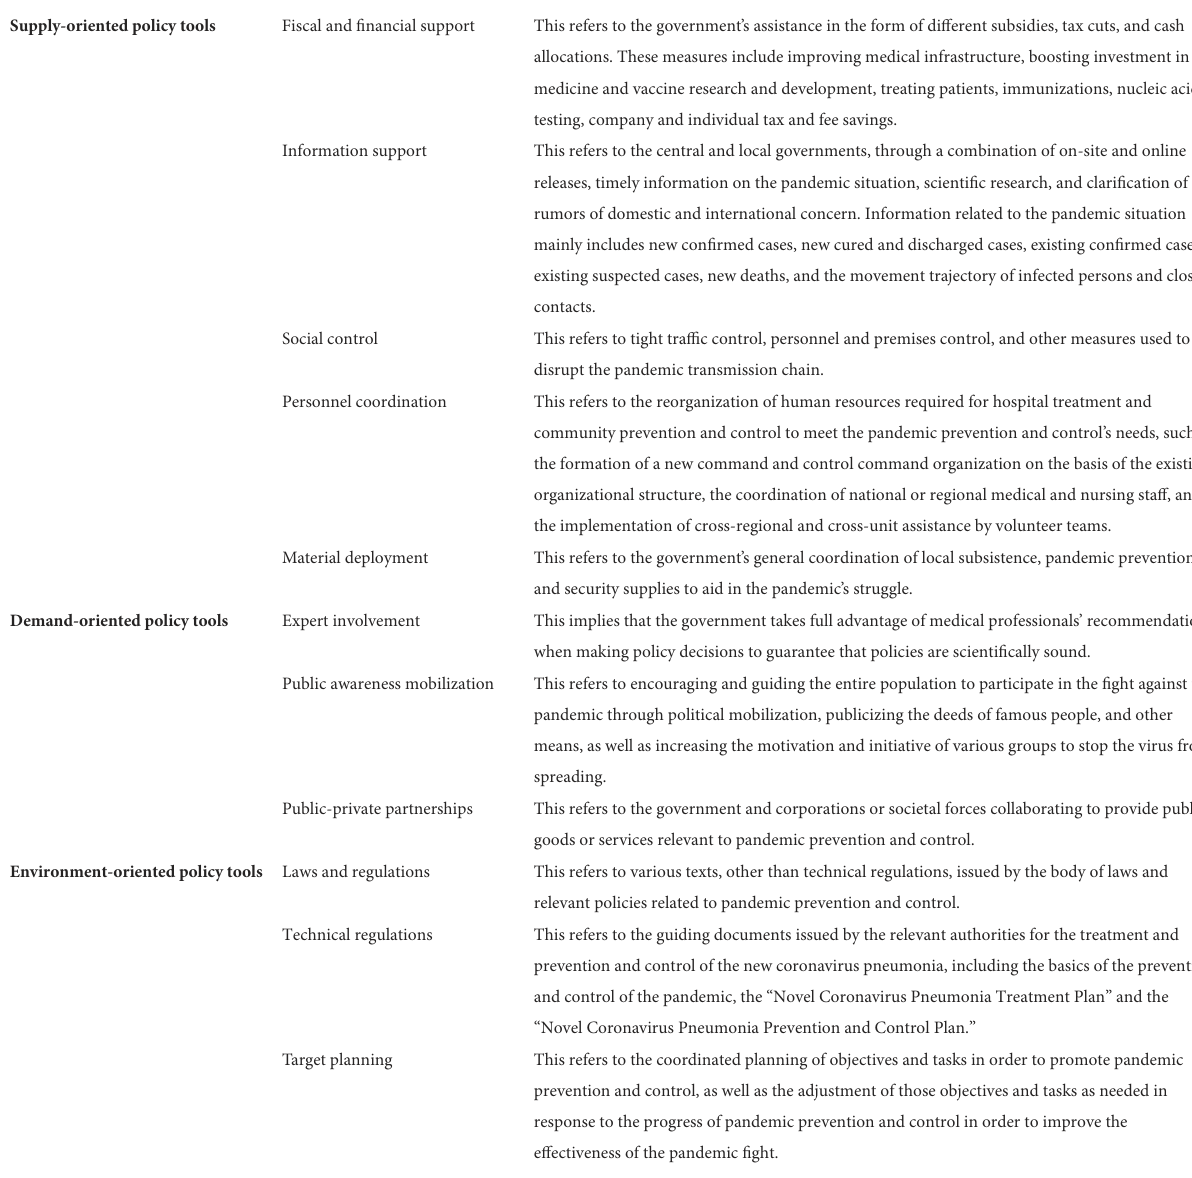
TABLE 1 The classification and description of policy tools in the fight against the COVID-19 in